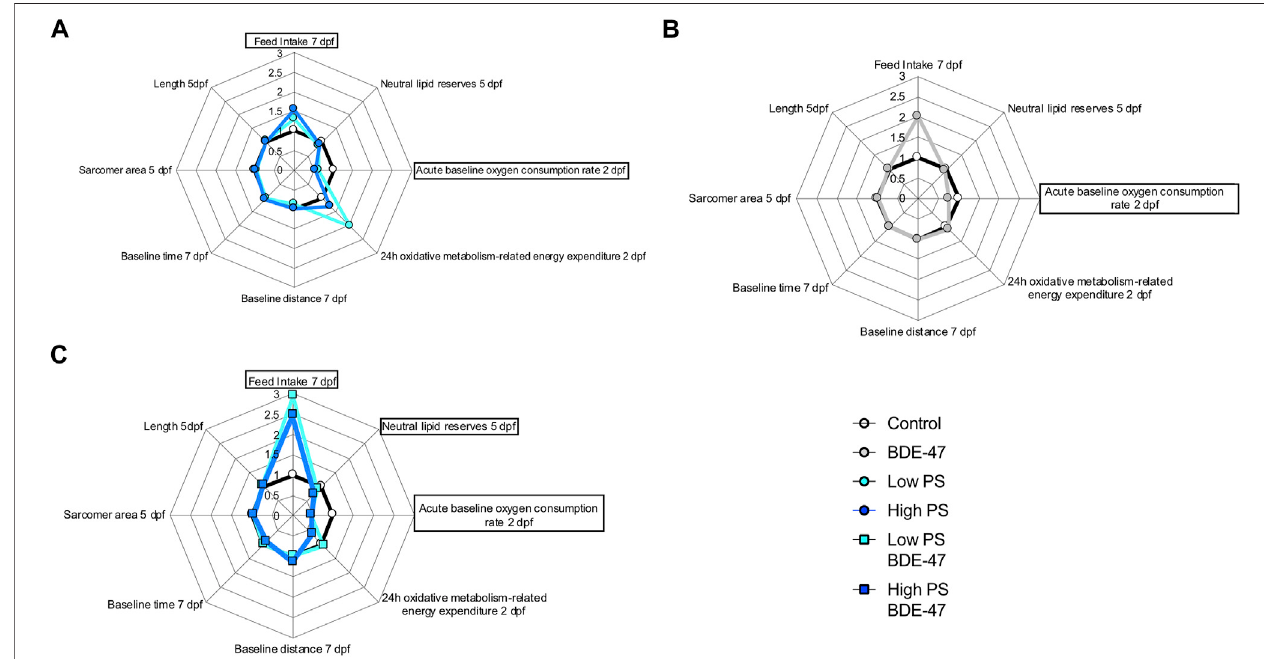
FIGURE 10 | Radar chart diagrams summarizing organismal level effects of different exposure treatments on the metabolic phenotype in developing zebra fi sh: Control, 2.5 ppm PS and 25 ppm PS exposures (A) Control and 10 ppt BDE-47 exposure, (B) Control and combined exposures of 2.5 ppm + 10 ppt BDE-47 and 25 ppm + 10 ppt BDE-47, (C) in comparison to vehicle control. Note that all average treatment group values have been normalized to control values (=1) and in some cases inverted so that datapoints > 1 indicate quanti fi ed parameters with a positive contribution to energy balance, while datapoints < 1 indicate parameters negatively contributing to organismal energy balance. Endpoints with signi fi cant effects of treatment are highlighted by surrounding rectangular shapes.